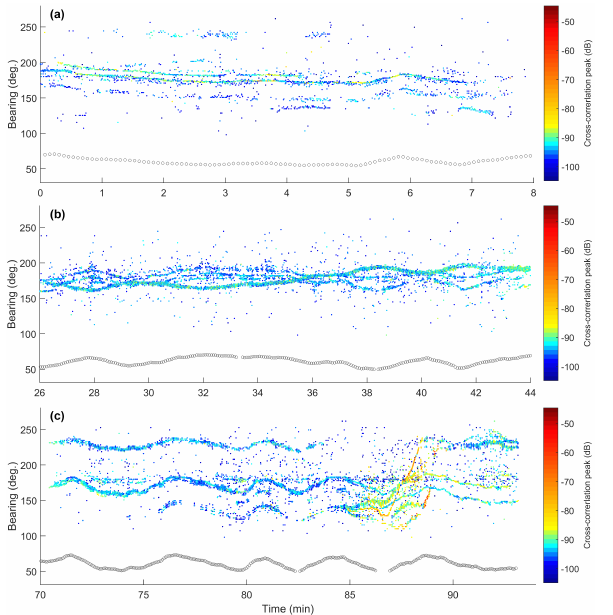
Figure 17. Estimated bearing angles from automatic detections of file 06, for three smaller time windows: (a) 0–8min, (b) 26–44min, and (c) 70–95min. The glider’s heading is shown as the line of gray circles below.